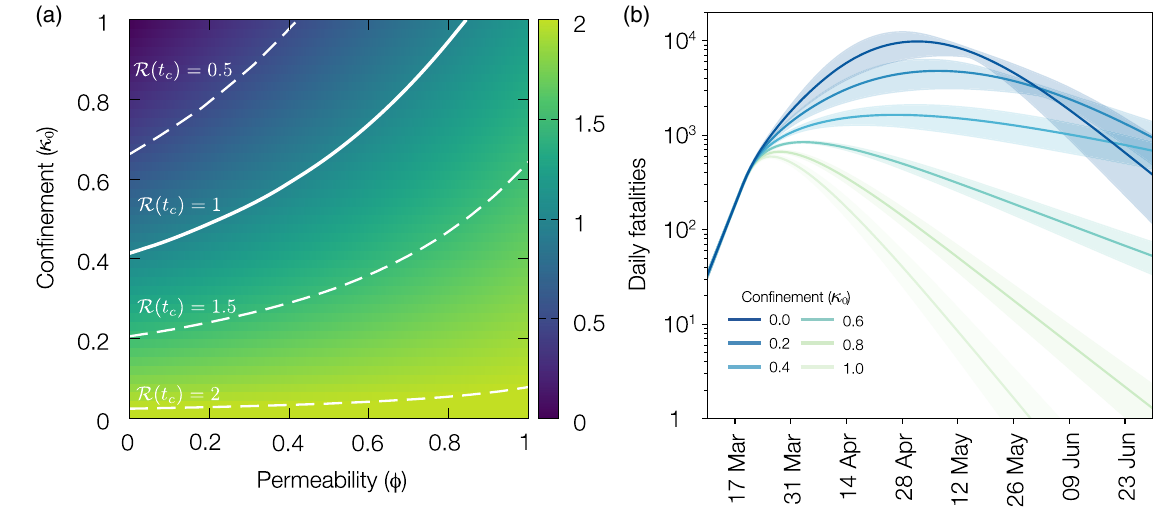
FIG. 5. Relationship between R , confinement, and permeability. (a) Effective reproduction number when mobility restrictions are (color code) as a function of the confinement κ 0 and the household permeability ϕ computed from Eq. (44). The white imposed R ð t c Þ 1 separating the different regimes for which enforcing the confinement leads to the flattening or solid line denotes the condition R ð t c Þ ¼ bending of the epidemic curve, respectively. The dashed white lines represent contour lines for different values of R ð t distancing value is fixed to δ ¼ 0 . 207 . See Appendix D for an analysis of the sensitivity of the results. (b) Temporal evolution of the daily fatalities as a function of the confined population κ 0 in a single intervention taking place on March